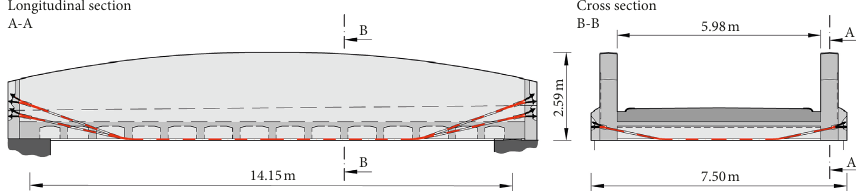
Figure 7: Another example of cable arrangement in the longitudinal and transverse directions for strengthening the U-shaped bridge with curved girders which was built in Vraˇzn ´ e in 1928 according to project documentation [23].